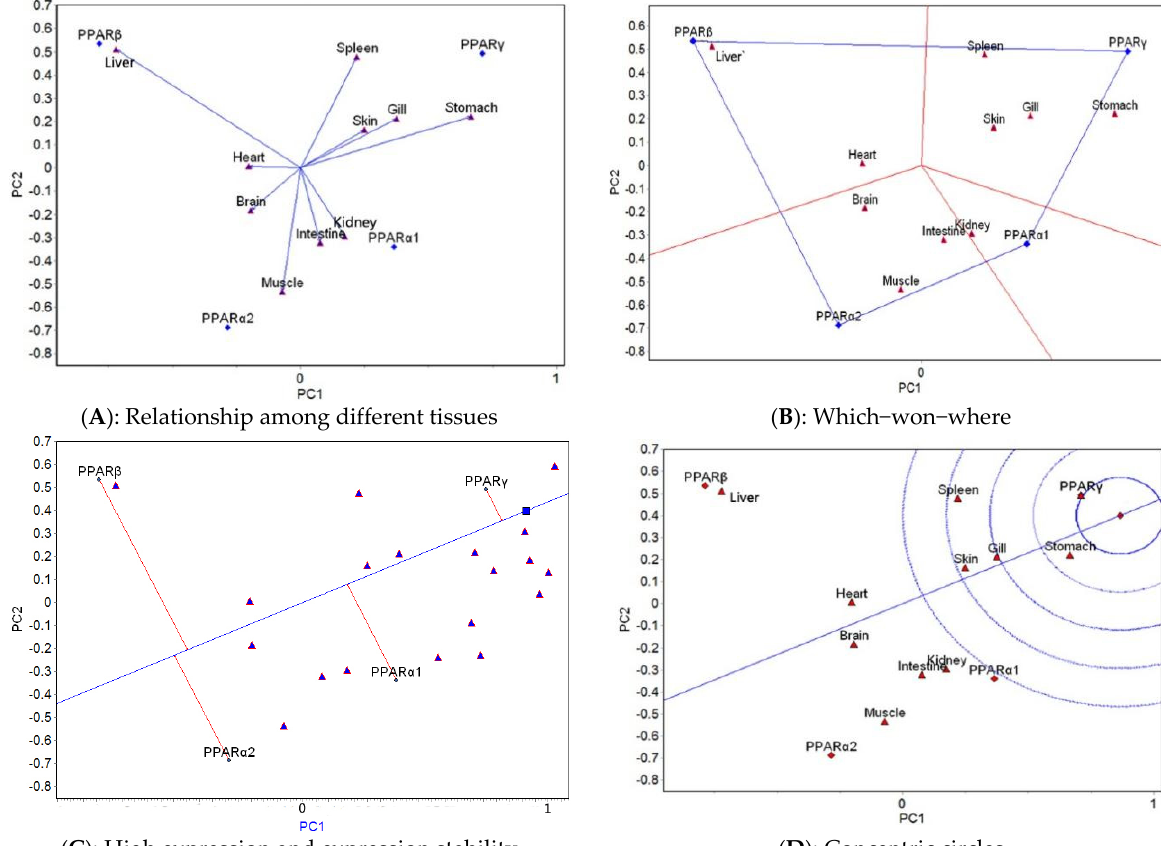
Figure 3. GGE biplots of PPAR genes in different tissues at 14 °C.